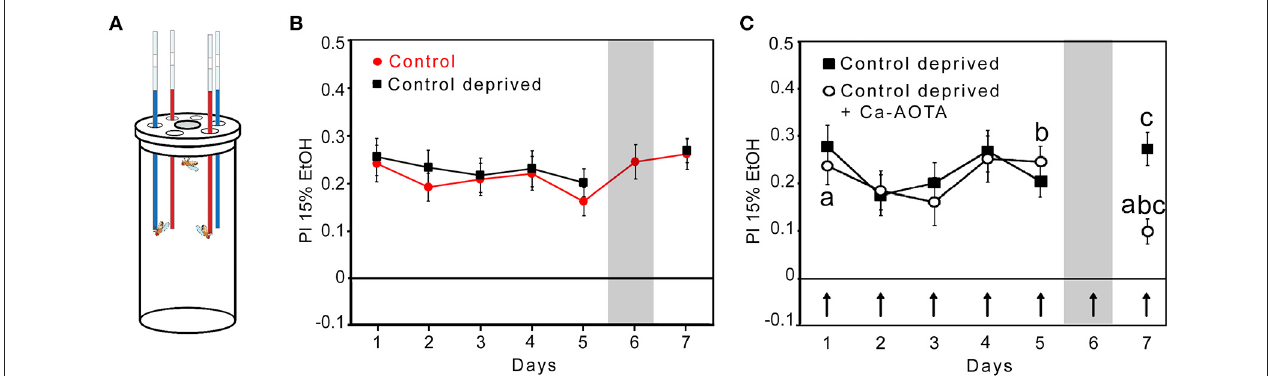
FIGURE 1 | Mechanistic similarities between ethanol consumption preference in flies and relapse in humans. (A) Capillaries are filled with 15% EtOH containing 5% sucrose (red) and 5% sucrose (blue). The preference to consume ethanol-containing food was defined by the relative difference between ethanol-enriched and non-ethanol-enriched food in comparison with the total amount of food consumed. (B) Control flies significantly preferred to consume ethanol-enriched food for 7 days. Ethanol-deprived flies on day 6 showed ethanol consumption preference again on day 7. N = 15 groups after deprivation. (C) Acamprosate (Ca-AOTA) mixed into all solutions of the experimental groups is indicated by an arrow. After deprivation, the flies showed significantly reduced ethanol consumption preference compared with the controls at day 7 (indicated by the letter “c”; P < 0.001), at day 5 prior deprivation (indicated by the letter “b”; P < 0.01), and the 1st day (indicated by the letter “a; P < 0.01). N = 28. Significance was determined using a two-tailed t test, and differences from random choice were determined using a one-sample sign test. The data are presented as the means ±